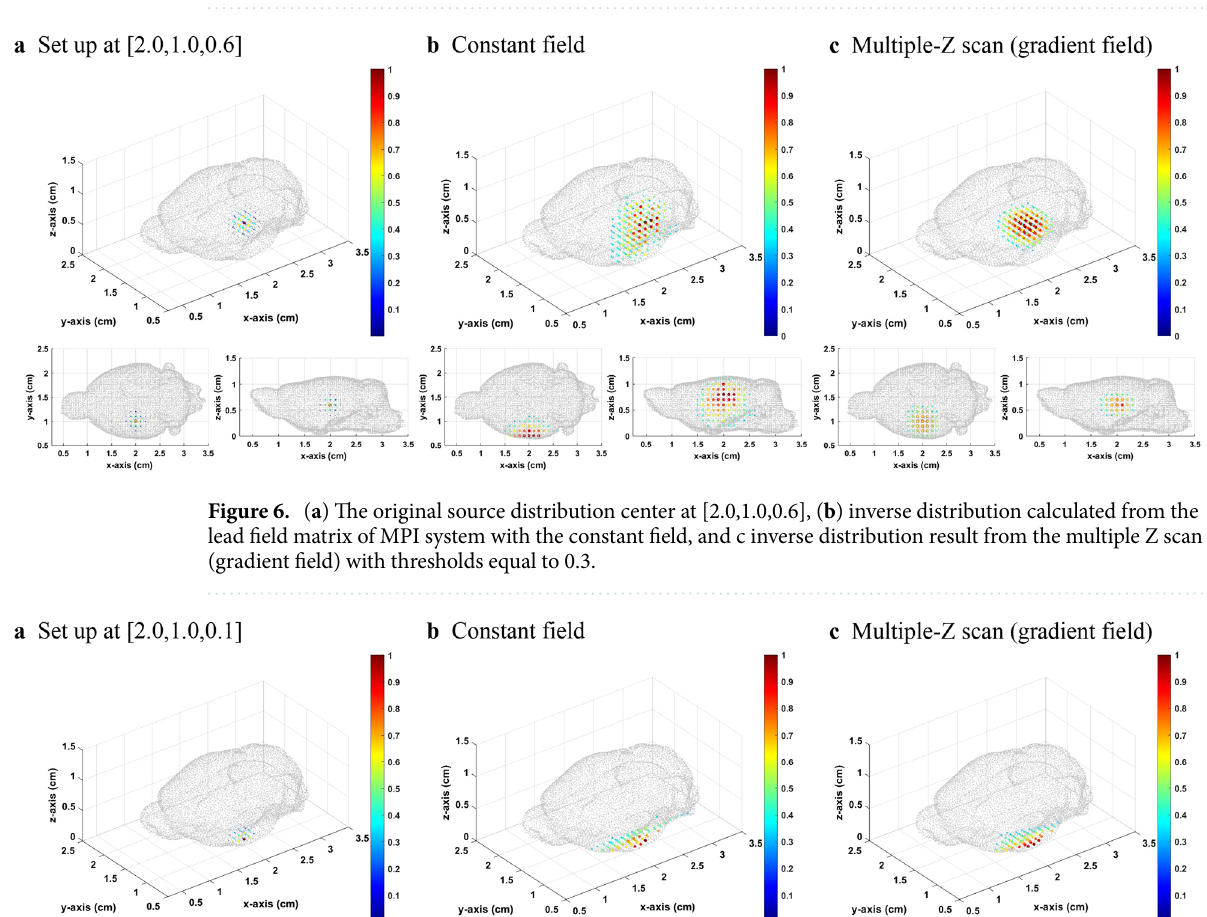
Figure 5. ( a ) The original source distribution center at [2.0,1.0,1.1], ( b ) inverse distribution calculated from the lead field matrix of MPI system with the constant field, and c inverse distribution results from the multiple Z scan (gradient field) with thresholds equal to 0.3.